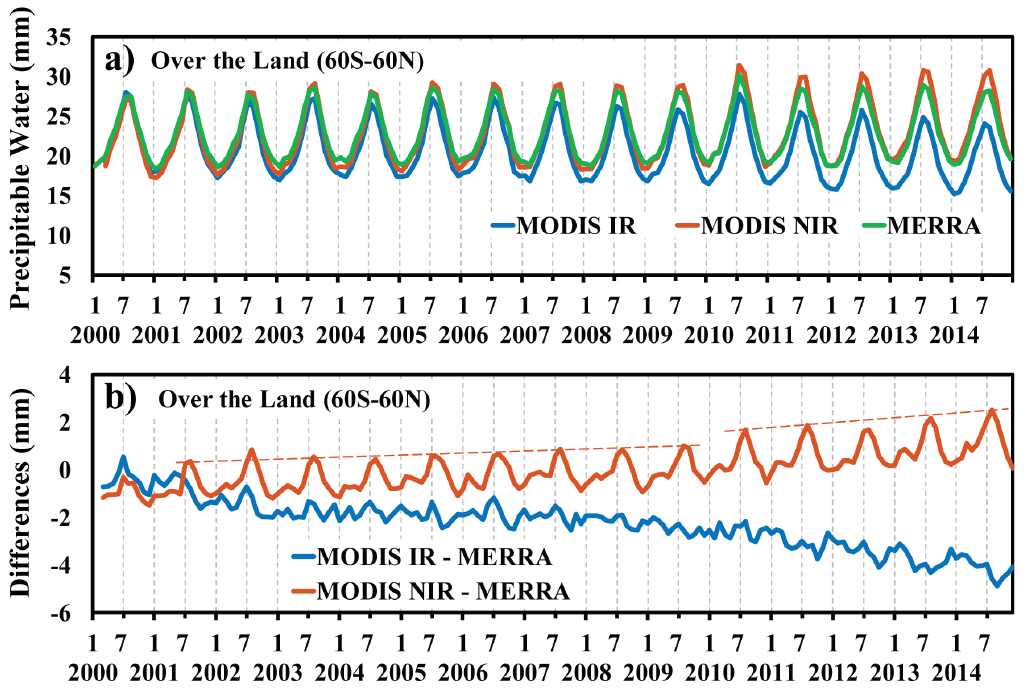
Figure 4. Monthly PW of MODIS IR (blue), MODIS NIR (red) and MERRA (green), averaged over ( a ) the land at 60°S‒60°N and ( b ) their differences for 2000‒2014. The red dashed lines denote shifts in MODIS NIR PW.